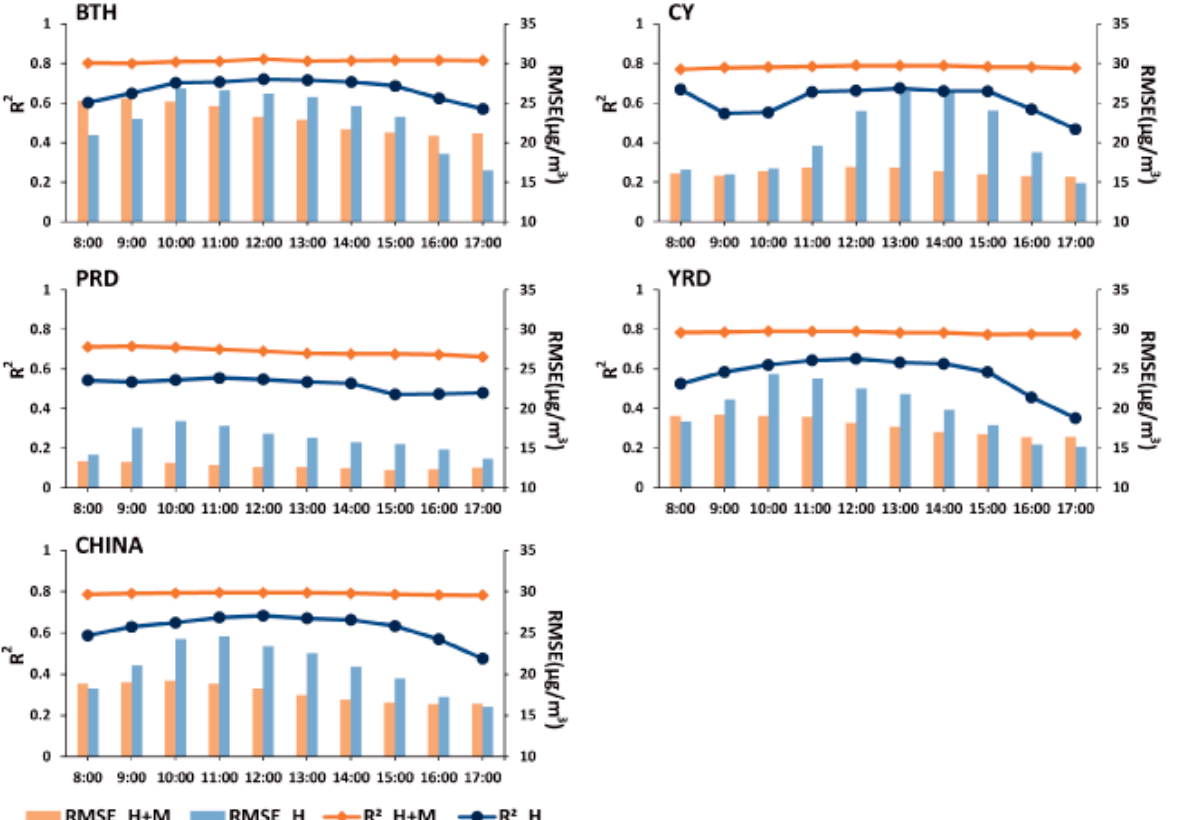
Figure 4. The temporal variation in CV R 2 and RMSE values in hourly AOD H - and AOD H+M -derived PM 2.5 over China and four typical regions.